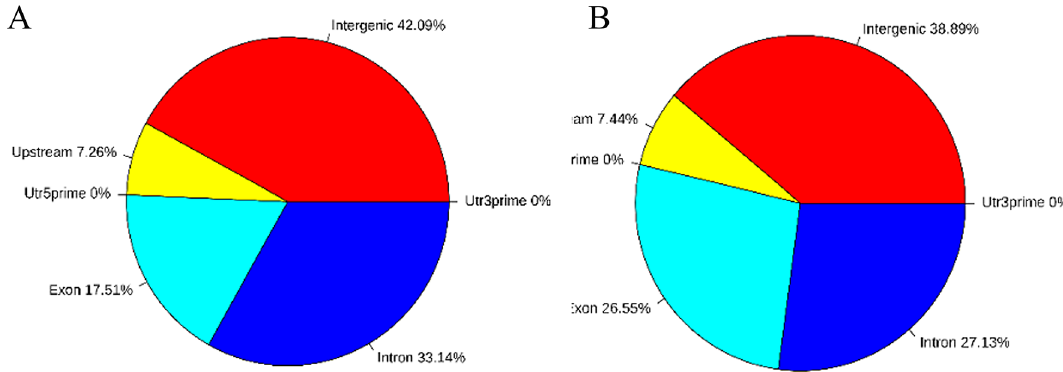
Figure 5. Pie charts of the distribution of the differentially methylated sites on different functional components ( A : CCGG sites; B : CCWGG